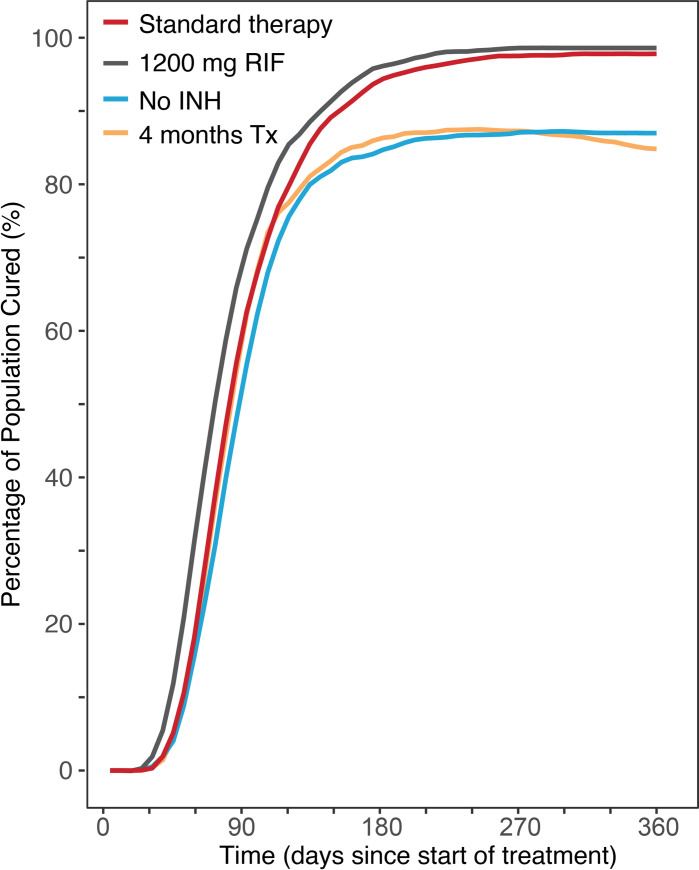
Reduced successful therapy outcome with variations of standard drug therapy.Comparison of patient outcomes for treatment of the median outcome of TB infection, with standard drug therapy (2HREZ/4HR) vs. median outcome of therapy excluding isoniazid, 1200 mg rifampin and reduced treatment time. Based on simulation of 5000 patients.